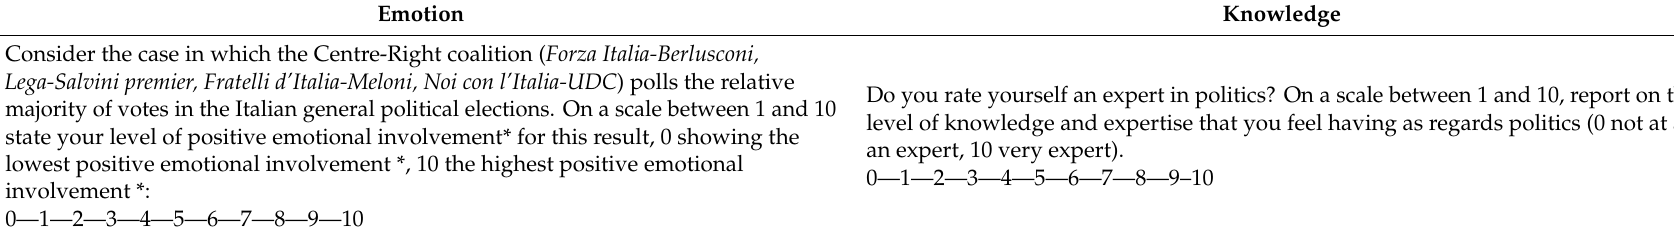
Table A2. Self-report questions in Milan 3.